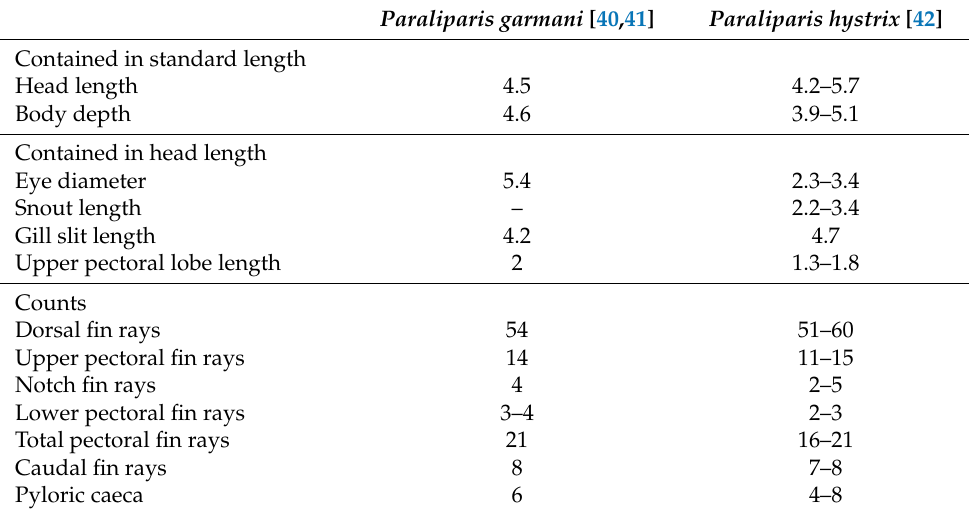
Table 2. Comparative morphological characters between P. garmani and P. hystrix .